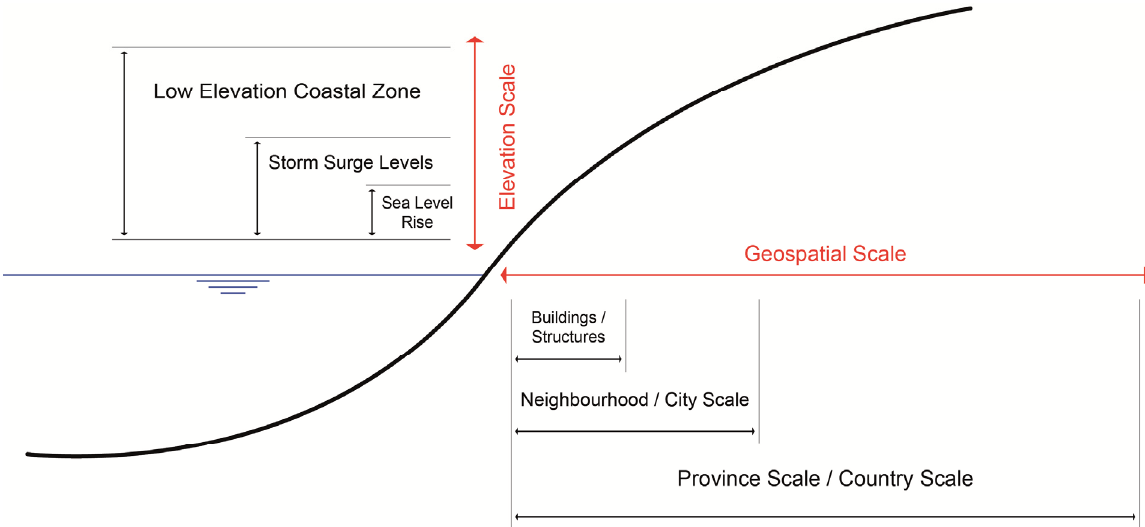
Figure 4. Different elevation and geospatial scales can be applied on coastal flood risk